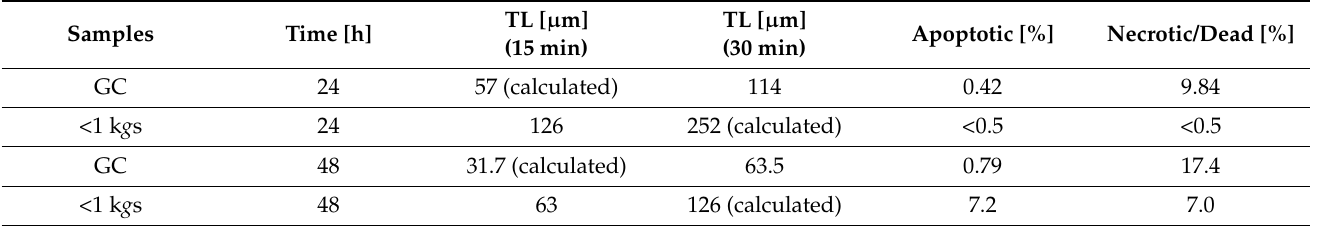
Table 3. Comparison of TL and the percentage of apoptotic/dead PMNs in GC [29] as well as after <1 kgs isolation after 24 h and 48 h,